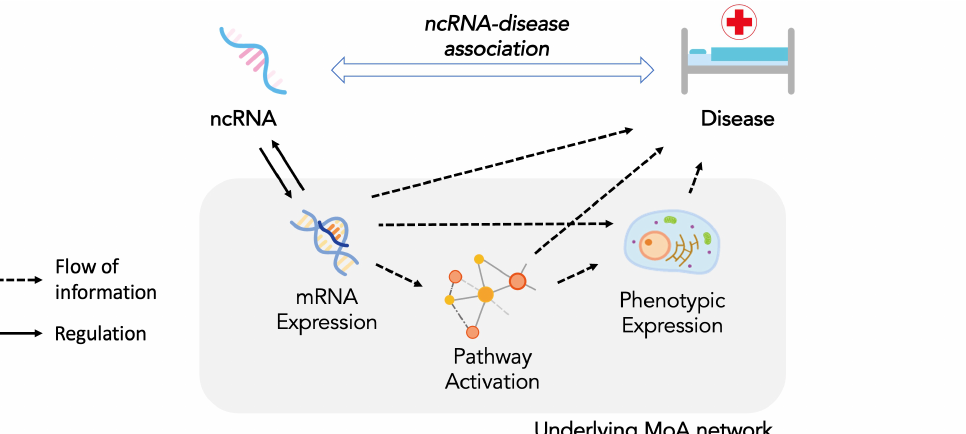
Figure 1. The MoA network of ncDA. NcRNA, regulating gene expression, alters the biological pathway and induces change of cellular phenotype. Aggregation of cellular phenotypes results in disruption of homeostasis and leads to a disease state.